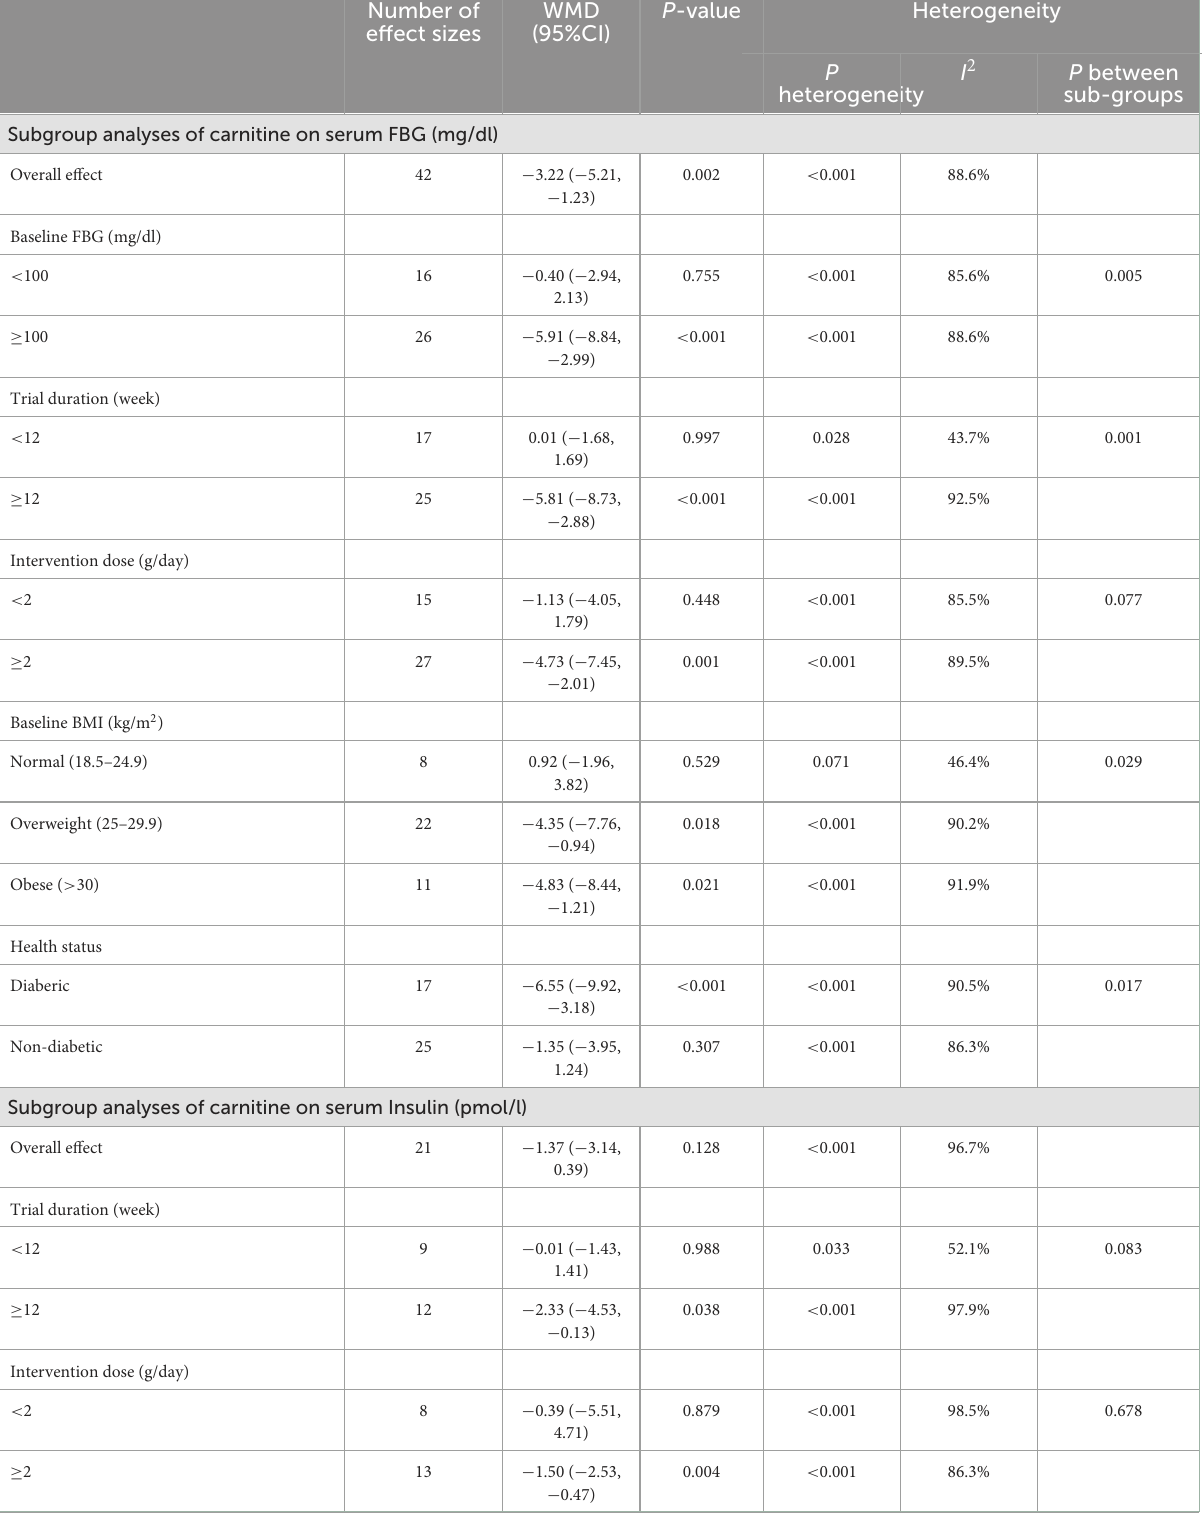
TABLE 3 Subgroup analyses of L-carnitine on glycemic indices in adults.